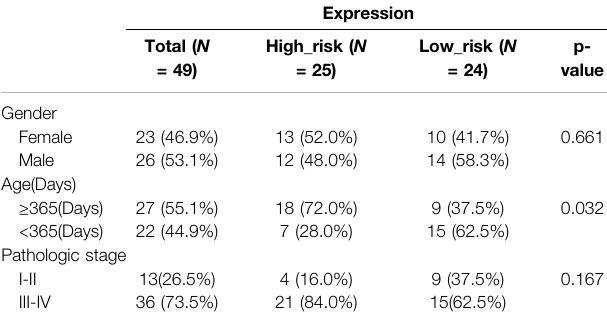
TABLE 2 | High and low risk groups association with clinical